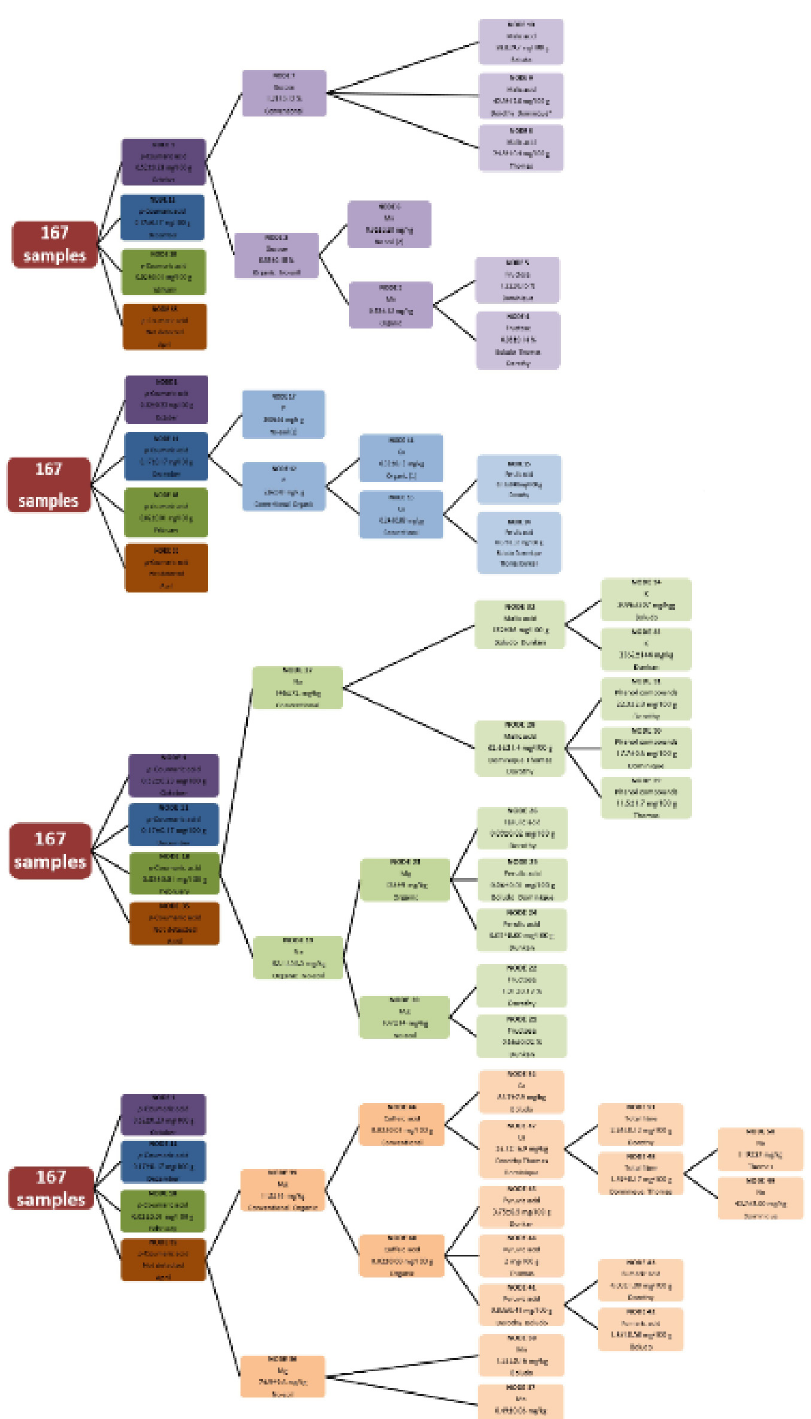
Fig 2. Tree-structured with main significant differences according to the GLM-AID analysis for the tomato samples. 2A October; 2B December; 2C February; 2D